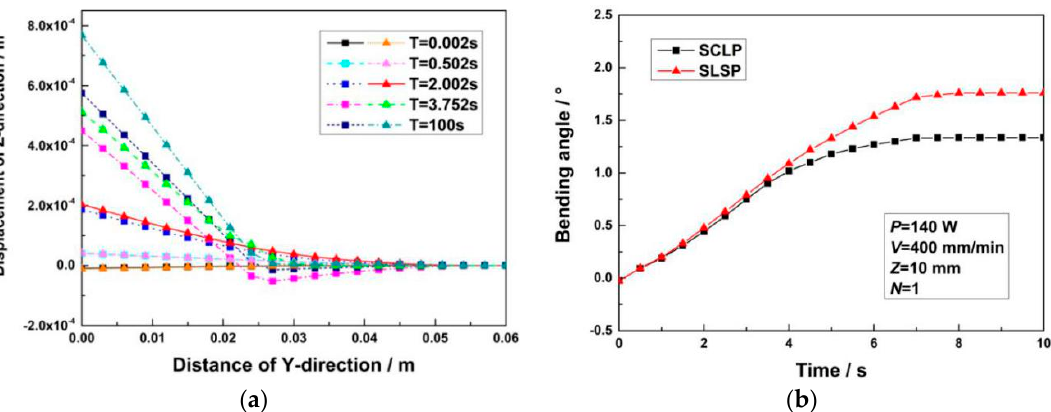
Figure 11. Comparison of Z-direction displacements between the SCLP and the SLSP: ( a ) Comparison of Z-direction displacements along Y-direction at different times; ( b ) comparison of bending angles at the midpoint of the free end at different times.